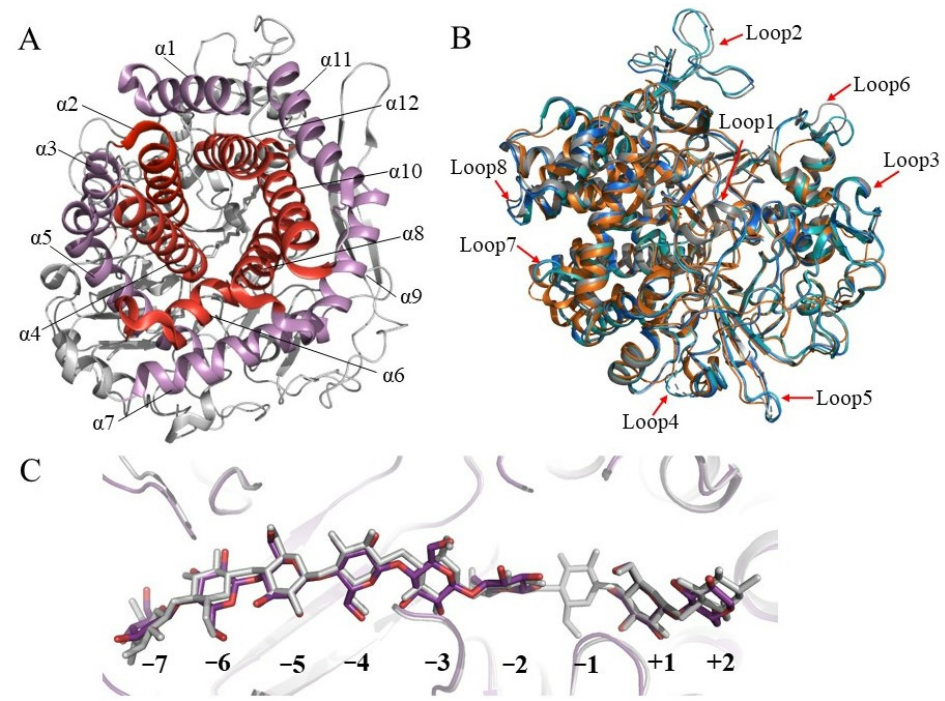
Figure 2. Structure and substrate sites of GH48 cellulase. ( A ) The overall structure of GH48 cellulase, CelS (PDB entry 5YJ6). The core ( α / α ) 6 barrels are colored red and violet, and the additional secondary structures are gray. The helices of the inner barrel with even numbers are in red while the helices of the outer barrel with odd numbers are shown in violet. ( B ) Superimposition of CelS (PDB entry 5YJ6, orange) and three Bacillus GH48 cellulases (PDB entry 5WMA, marine; PDB entry 5BV9, cyan; PDB entry 7KW6, gray). The extra loops of Bacillus GH48s are indicated by red arrows. ( C ) The substrate sites of GH48 cellulase. The cellobiose in subsites +1 and +2 and cellohexaose in subsites − 2 to − 7 in CelS-cellohexaose are shown in deep purple (PDB entry1L2A). The thiocellodecaose located at subsites +2 to − 7 in CelF E55Q/thiocellodecaose complex are colored in gray (PDB entry 2QNO). The figure was prepared using PyMOL (Schrödinger).